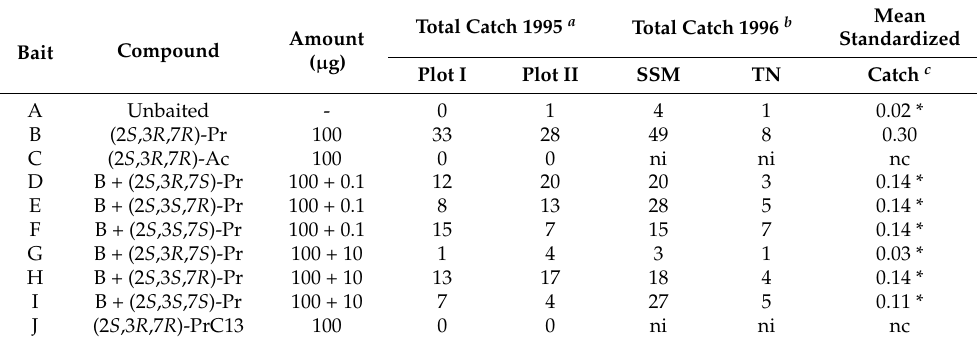
Table 2. Catch of male Diprion similis in traps baited with acetate (-Ac, bait C) or propanoate (-Pr, baits B, D-I) of (2 S ,3 R ,7 R )-3,7-dimethylpentadecan-2-ol (diprionol), alone or in combination with other stereoisomers, or with its homolog propanoate of (2 S ,3 R ,7 R )-3,7-dimethyltridecan-2-ol (-PrC13, bait J).